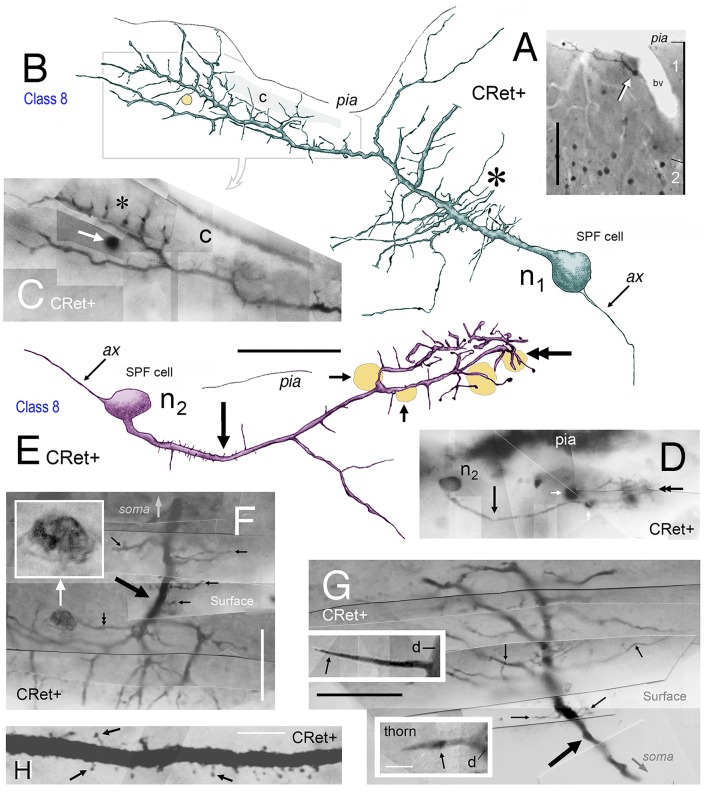
(A) Photomicrograph showing a class 8 CRet+ SPF cell (arrowed) in area 46v (oblique view). Numerous CRet+ neurons are present in layer 2. The SPF cell is closely associated with a penetrating blood vessel (bv). Scale bar: 200 μm. (B) Reconstruction of the SPFcell (n1) seen in (A) taken from three consecutive sections. Note the long fibrous processes associated with the primary dendrite (asterisk). A small-diameter penetrating capillary (c) is indicated. Axonal process (ax). Scale bar: 50 μm. (C) Photographic montage of the region indicated in (B). Penetrating capillary (c). Thorns on dendritic processes (asterisk). A dark circular profile of cellular debris is indicated (white arrow). Scale bar: 25 μm. (D) Class 8. Photomicrograph of another CRet+ SPF cell (n2) in area 25. Dark profiles of cellular debris are indicated (white arrows). Scale bar: 25 μm. (E) Reconstruction of SPF cell (n2). Note the long primary process (arrow) and the terminal densely thorned plexus (doubled headed arrow). Axonal process (ax). Dark profiles of cellular debris as in (D). Scale bar: 50 μm. (F,G) Photomicrographic montages showing fine processes (small arrows) arising perpendicularly from CRet+ labeled primary dendrites (thick arrows) from SPF cells in areas 24/32. In (F), an irregular dark profile is associated with one process (double headed arrow; inset). Note the fan-like arrangement of processes in (G). Scale bar: 25 μm. Insets in (G) show thorns on SPF cells. Dendritic stem, d. Scale bar: 25 μm. (H) Primary dendritic segment of a SPF cell in area 46. Numerous dendritic spines with different morphologies (arrows). Scale bar: 10 μm.